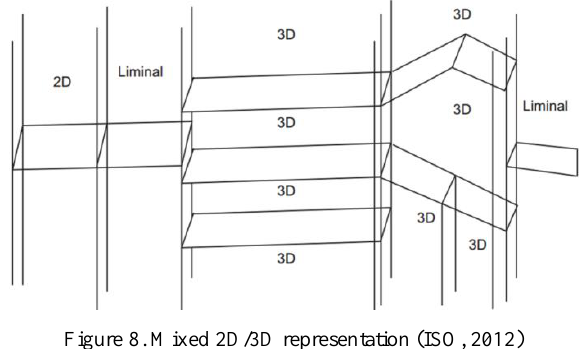
Figure 8. Mixed 2D/3D representation (ISO,